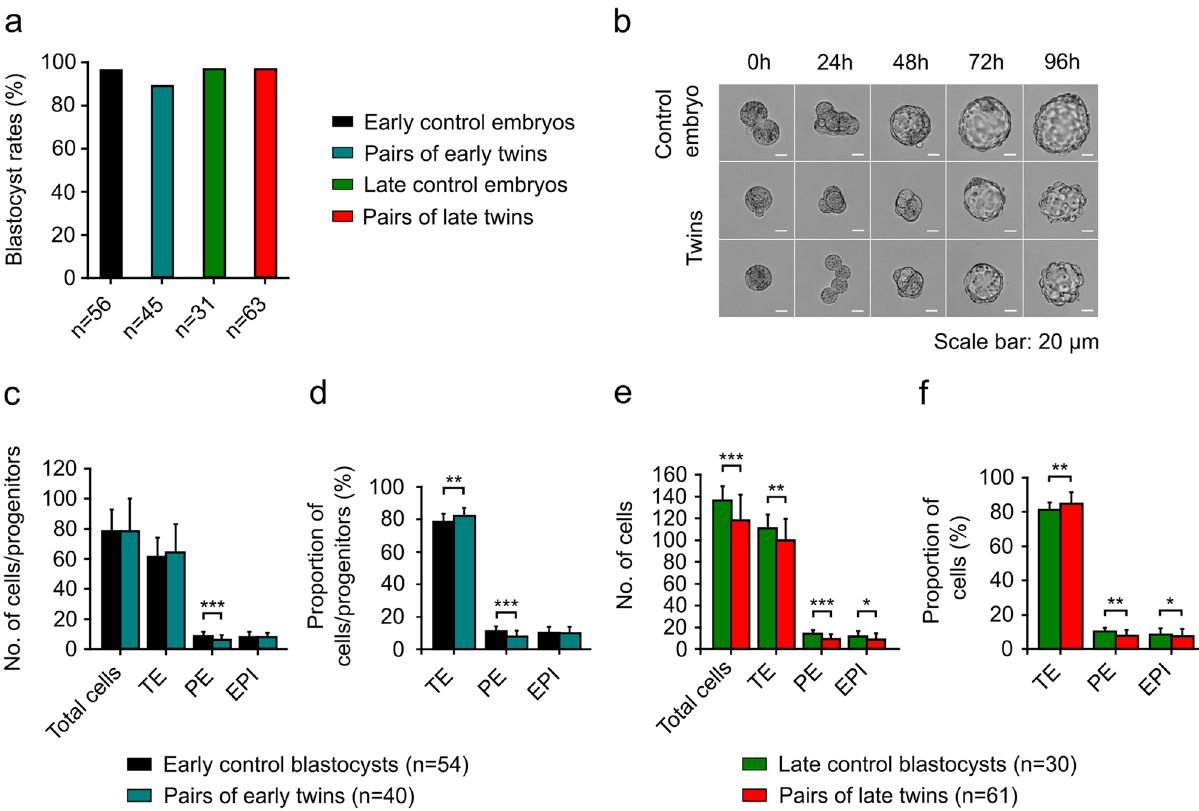
Figure 1. Cell lineage allocation in monozygotic twin blastocysts and controls. ( a ) Blastocyst development from 2-cell stage single blastomeres after 72 (early variation) or 96 (late variation) hours of in vitro culture. The data were obtained from 7 experiments. The results were compared using Chi-squared test. ( b ) Representative brightfield images showing embryos developed from 2-cell stage single blastomeres after 24, 48, 72, and 96 h of in vitro culture. Scale bar: 20 µm. ( c ) Quantitative analysis of the total number of cells, the number of CDX2- positive cells (TE), as well as the numbers of SOX2-positive (EPI) and SOX17-positive (PE) progenitors in pairs of early twin blastocysts. ( d ) The percentage of TE cells, as well as EPI and PE progenitors in pairs of early twin blastocysts. ( e ) Quantification of the total number of cells, as well as the numbers of TE, EPI, and PE cells in pairs of late twin blastocysts. ( f ) Percentages of TE, EPI, and PE cells relative to the total number of cells in pairs of late twin blastocysts. For ( c , d , e , and f ), normality of the data was verified with the Kolmogorov–Smirnov test, and Student’s t-test was used for calculations. * p < 0.05, ** p < 0.01, *** p < 0.001. Error bars indicate standard observed in EPI in control blastocysts (8.0 ± 3.5). The only difference observed between the groups was associated with the PE lineage (Fig. 1c; Supplementary Tables S1, S2). The mean number of PE progenitors was significantly lower in twins (6.2 ± 3.2) compared to control embryos (8.7 ± 2.8; p = 0.0001). We also analyzed the proportions of cells contributing to cell lineages in twin and control blastocysts (Fig. 1d; Supplementary Tables S1, S2). In the early twin blastocysts, the proportion of TE cells was higher than in control blastocysts (82.1% ± 4.8% and 78.7% ± 4.8%; p = 0.005). Twin embryos also had a lower proportion of PE progeni- tors than controls (7.9% ± 3.5% and 11.0% ± 3.3%; p < 0.0001). The fraction of EPI progenitors was the same in both groups (10.0% ± 4.0% for each group).